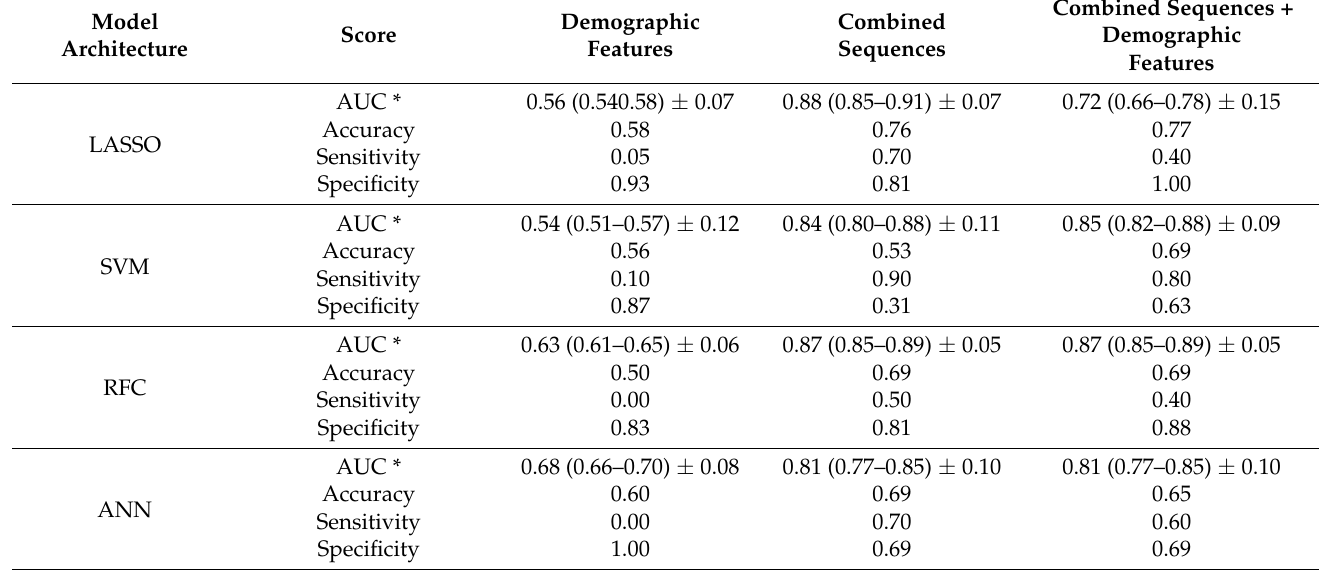
Table 2. Performance of the machine-learning models on the external test set using demographic information or radiomic features only, as well as combining radiomic features and demographic information for the following model architectures: least absolute shrinkage and selection operator (LASSO), support vector machine (SVM), random forest classifier (RFC), and an artificial neural network (ANN). External performance represents the values yielded when a final cross-validation step considering only the best 150 best hyperparameter sets was implemented to predict the external test set. Combined Sequences + Demographic Combined Demographic Features Sequences